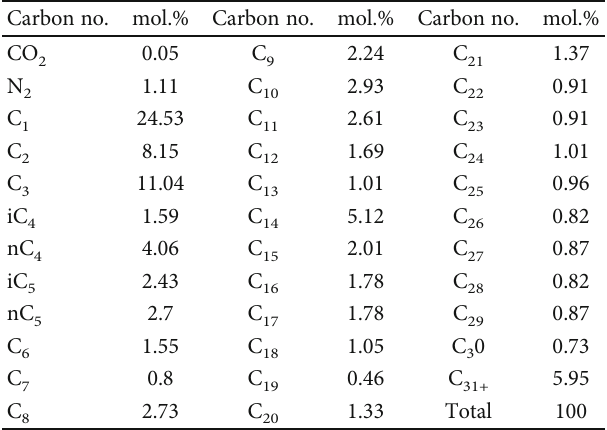
Table 2: Components of the oil sample under the reservoir conditions (20.8 MPa, 84 ° C).